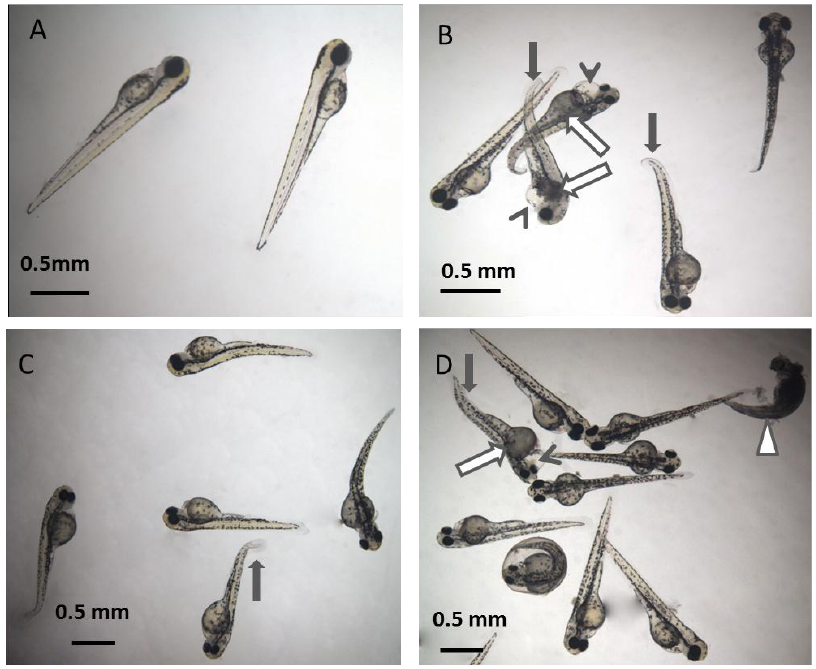
Figure 2. Representative photos of zebrafish ( Danio rerio ) embryos exposed to phthalates and phthalate mixture. ( A ): control; ( B ): 0.50 ppm BBP; ( C ): 1.50 ppm DBP; ( D ): mixture containing 0.50 ppm of BBP, DBP, DEHP, DIDP, DIDP and DNOP, respectively. Representative toxicity symptoms caused by phthalates includes death (empty triangle), tail curvature (solid arrow), necrosis (empty arrow), cardio edema (arrowhead) and no touch